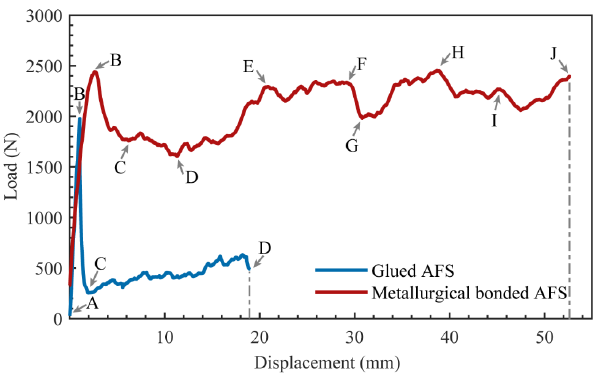
Figure 13. Load-displacement curves of metallurgical bonded and glued AFS in the three-point bending experiment.